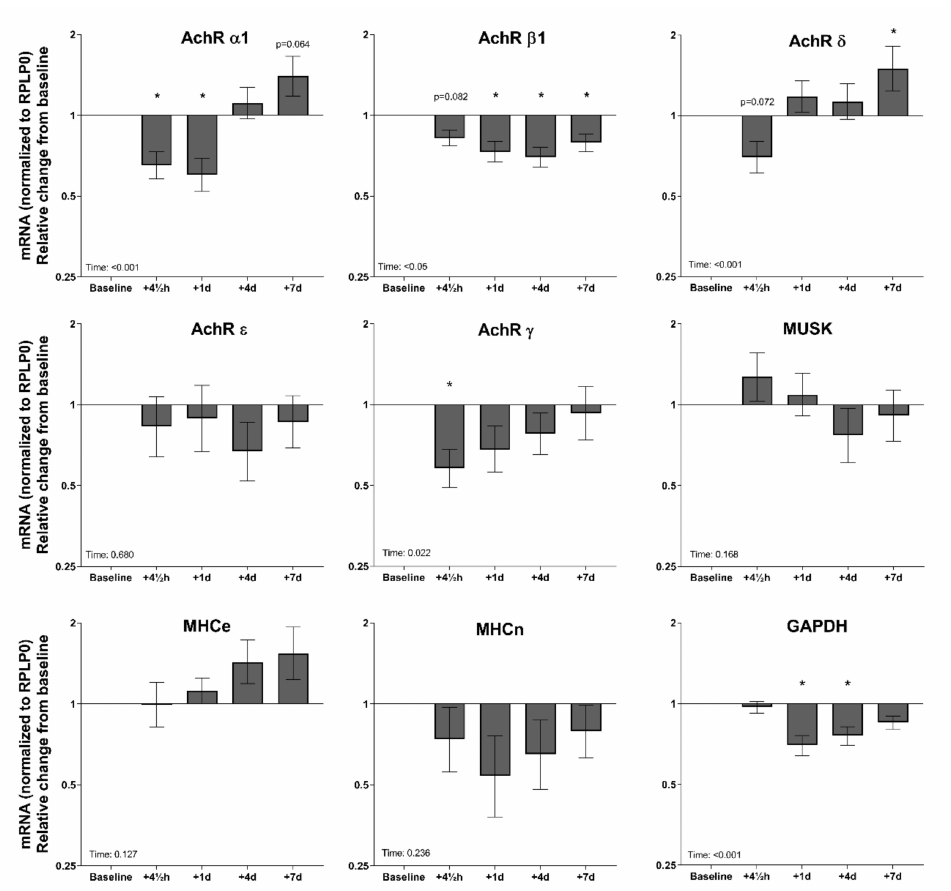
Figure 5. Gene expression in muscle biopsies of 25 healthy elderly men ten days before (baseline) and 4.5 h, one day, four days, and seven days after a single bout of exercise. mRNA data were normalized to RPLP0 and are shown as geometric means ± back-transformed SEM, relative to baseline. * p < 0.05 vs. baseline. Tendencies are written. AChR: acetylcholine receptor; MuSK: muscle-specific-kinase; MHCe: embryonic myosin heavy chain; MHCn, neonatal myosin heavy chain; NCAM, neural cell adhesion molecule; GAPDH: Glyceraldehyde-3-Phosphate Dehydrogenase; RPLP0: Ribosomal Protein Lateral Stalk Subunit